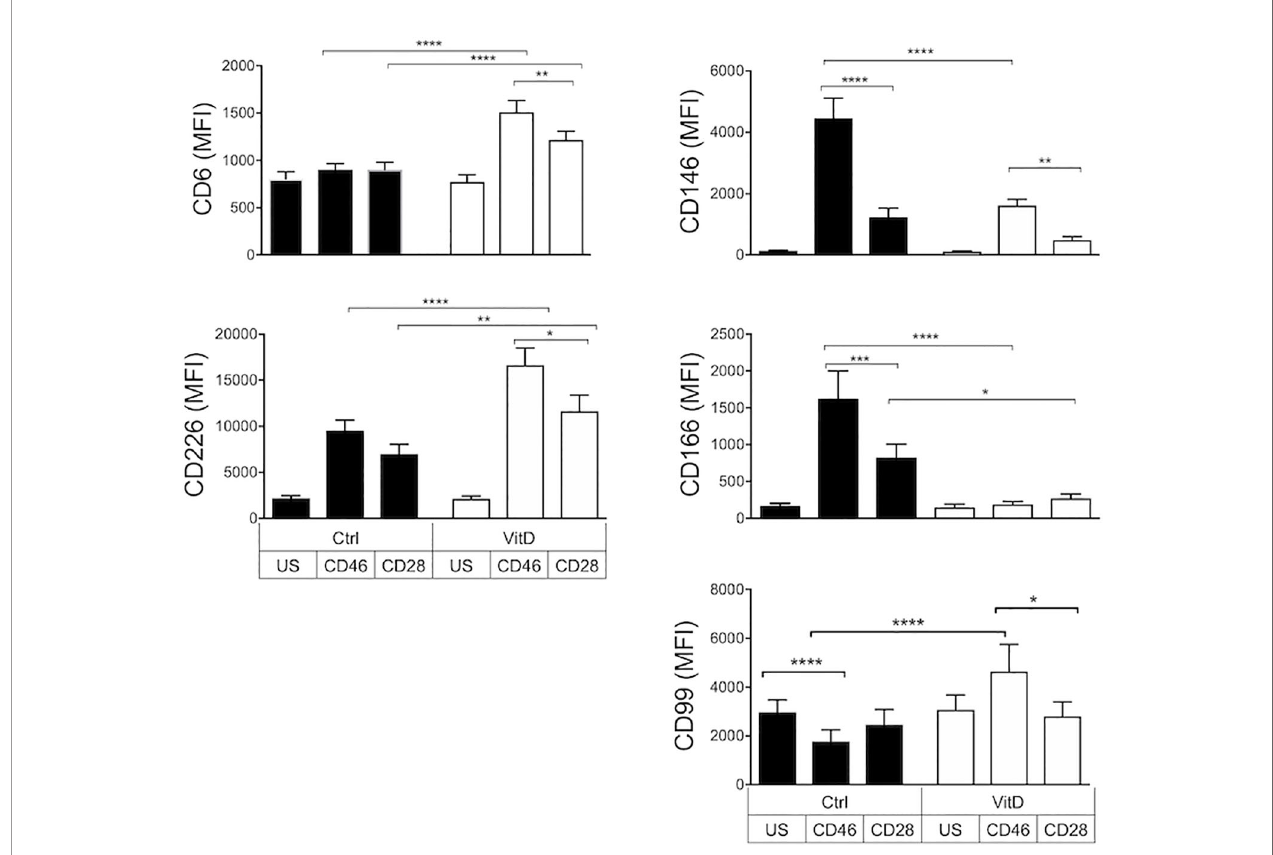
FIGURE 2 | 1,25(OH)2D3 differentially modulates the expression of cellular adhesion molecules on activated T cells depending on their activation pathway. Human CD4+ T cells were left unstimulated (US) or were activated with anti-CD3 and anti-CD28 or anti-CD46 as indicated, in the presence or absence of 1,25(OH)2D3 (VitD). After 4 days, expression of CD6, CD226, CD146, CD166, and CD99 was assessed by fl ow cytometry (mean ± SEM, n= 24 (n= 15 for CD99), one way ANOVA with Holm-Sidak ’ s multiple comparisons post hoc test). *: p<0.05 to 0.01, **: 0.001 to 0.01, ***: 0.0001 to 0.001, and ****: <